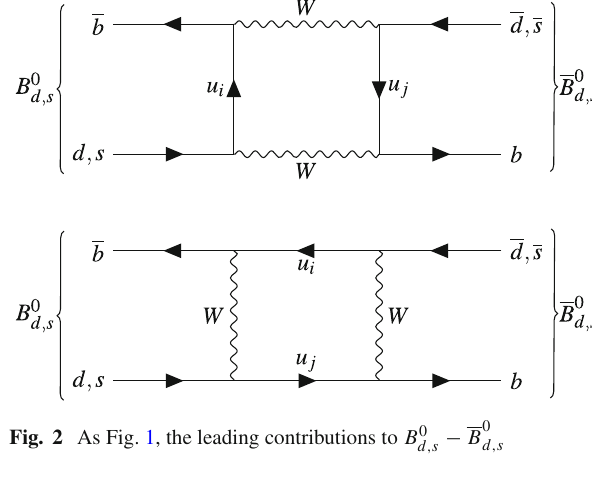
Fig. 2 As Fig. 1, the leading contributions to B 0